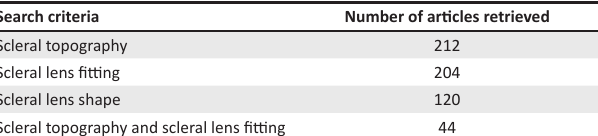
TABLE 1: Different combinations of searching criteria and the number of articles